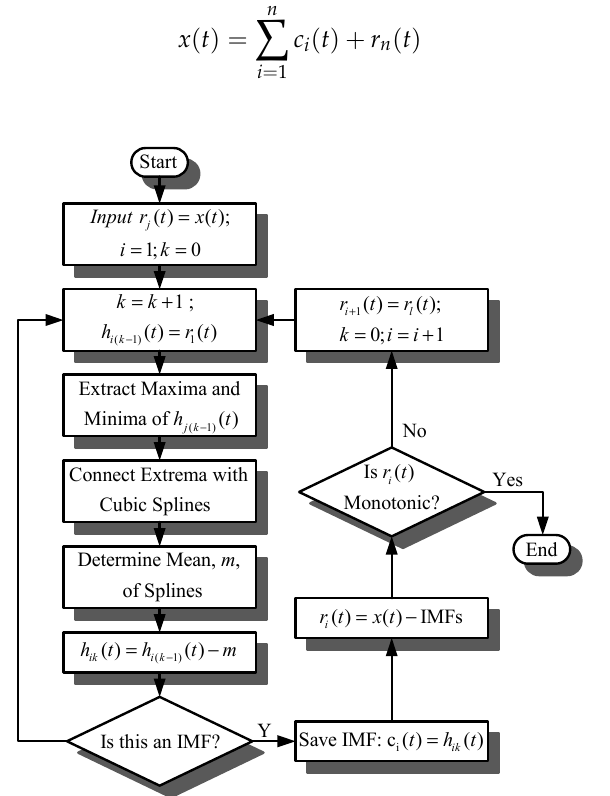
Figure 2. Flowchart of empirical mode decomposition (EMD) decomposition.